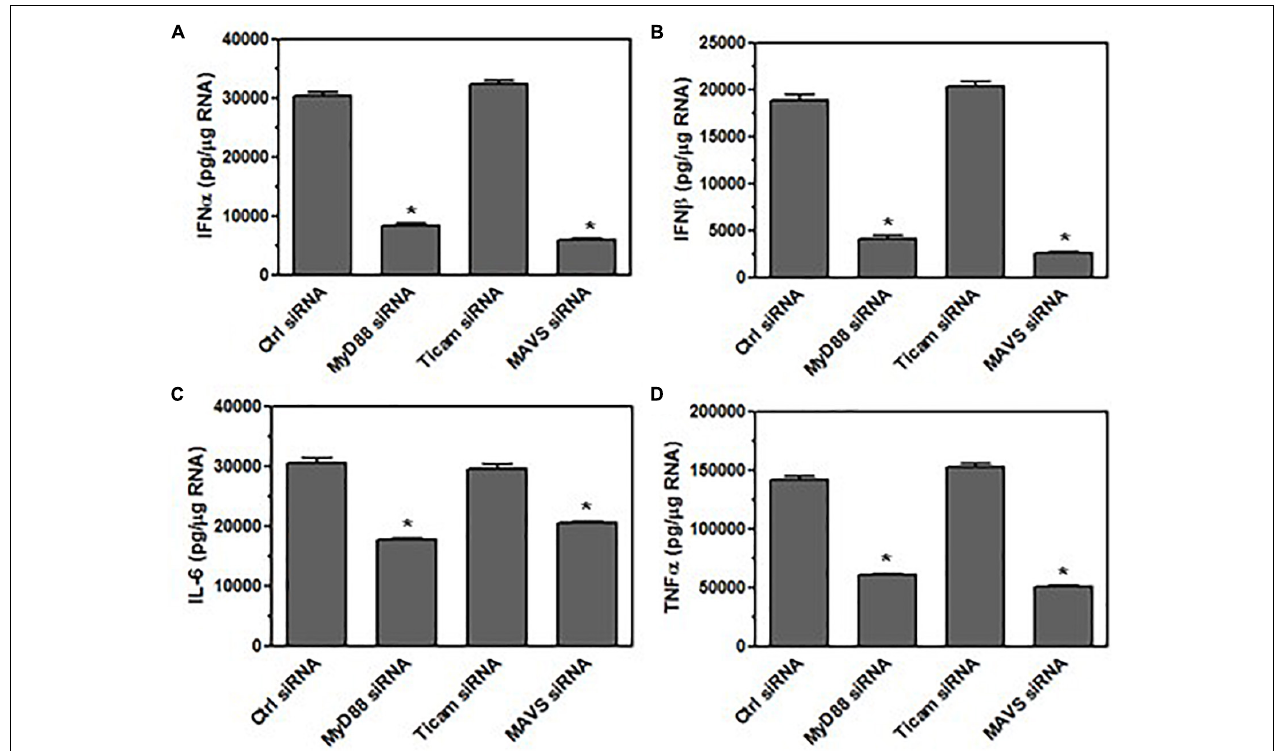
FIGURE 6 | Bystander microglia are activated by viral RNA in exosomes from TMEV-infected microglia via innate immune receptors. Microglia were transfected with siRNA for MyD88, TICAM-1, MAVS, or control (6 h). Exosomes were isolated from TMEV-infected microglia and placed on the transfected microglia for 24 h. Microglia were lysed, RNA isolated, converted to cDNA, and analyzed by real time PCR for expression of IFN α (A) , IFN β (B) , IL-6 (C) , and TNF α (D) . Significant difference was determined by the one way ANOVA and Bonferroni’s multiple comparison test (* p < 0.001) based on control siRNA transfected microglia. These are representative graphs from one experiment of three independent repeated